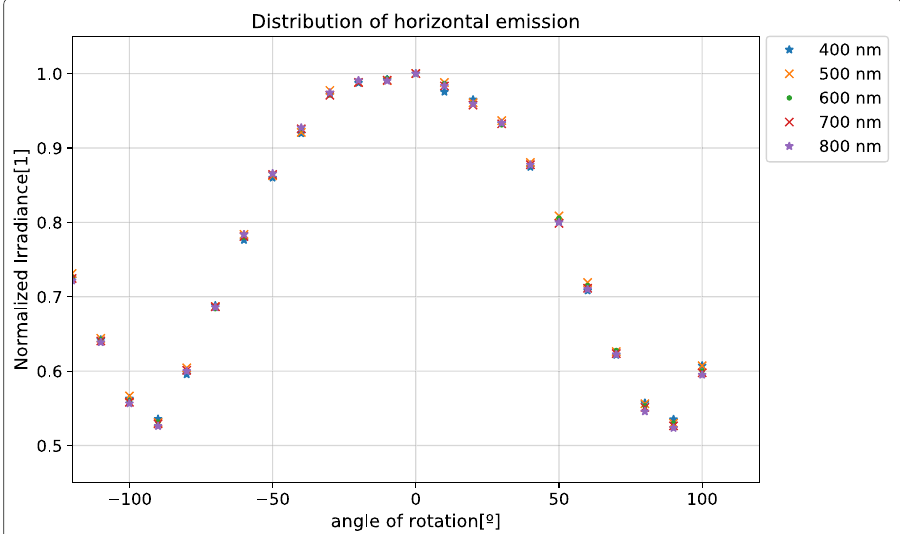
Distribution of radiant exitance as a function of the horizontal rotation